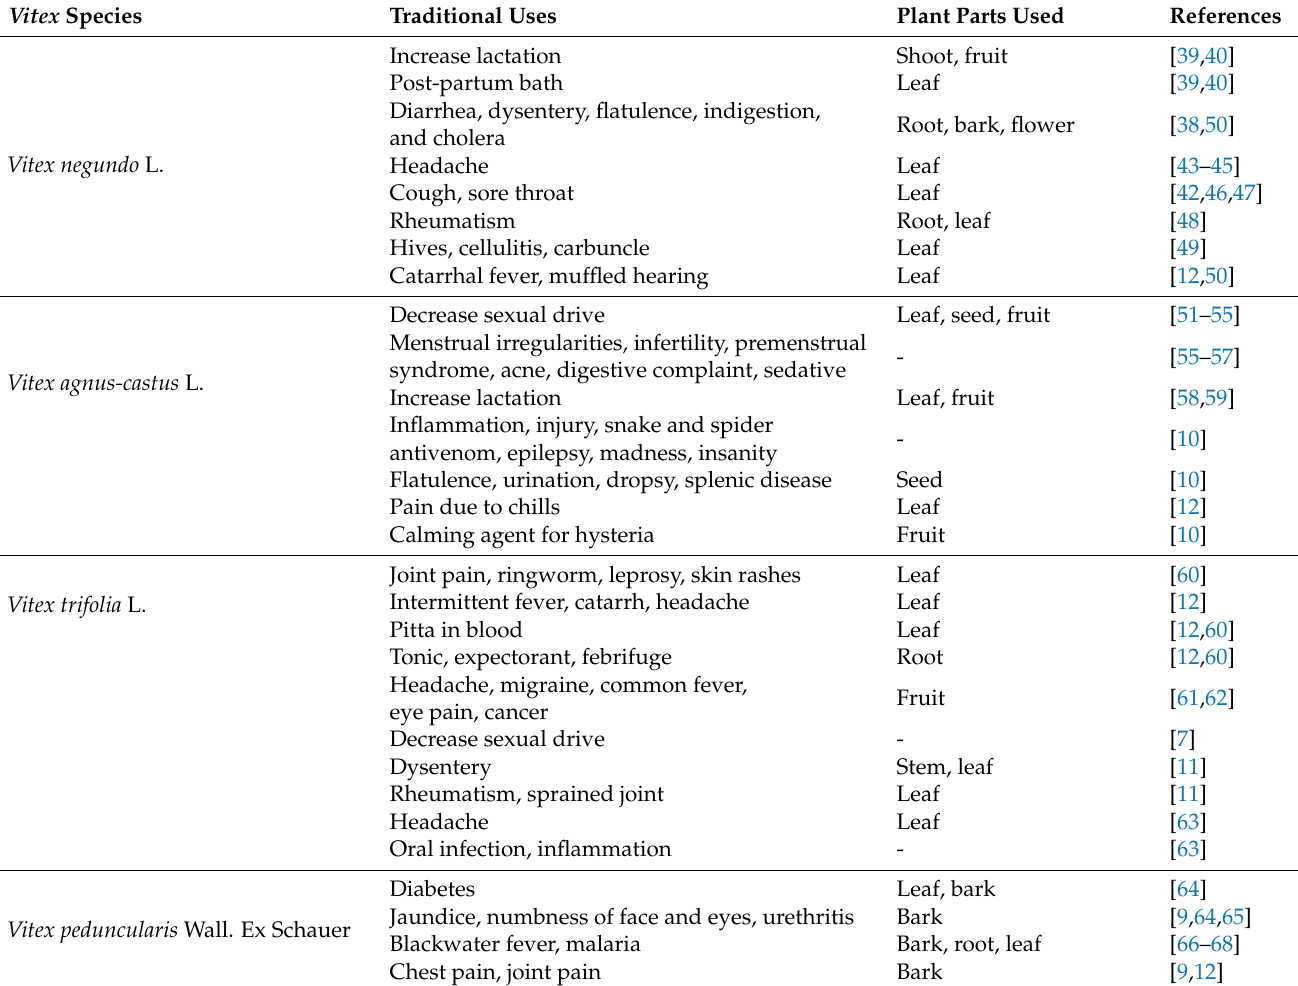
Table 1. Summary of traditional applications of various Vitex species in